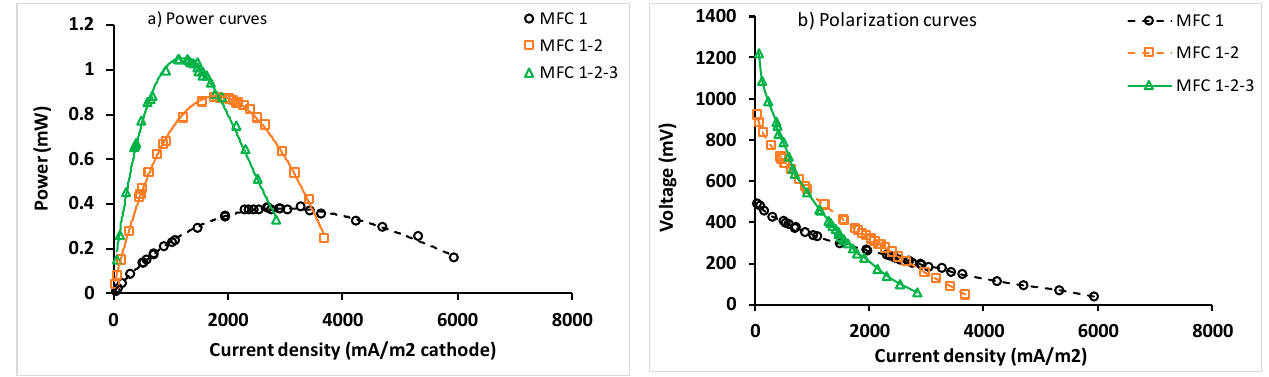
Figure 5. Performance of the MFCs in series: ( a ) power curves and ( b ) polarization curves for the MFC 1, MFC 1-2, and MFC 1-2-3 settings.